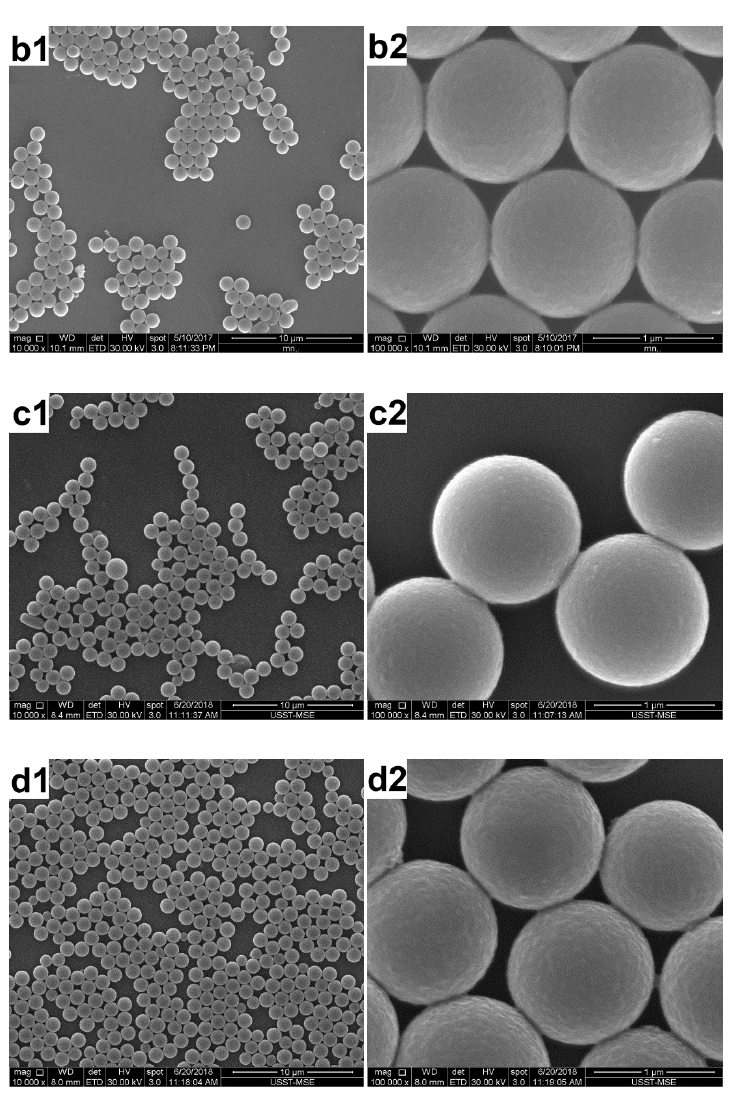
Figure 4. SEM images of the products prepared with a fixed amount of PS (0.4 g), and varied AT amounts at various magnifications: ( a ) 0.4 g (run 1); ( b ) 0.3 g (run 2), ( c ) 0.2 g (run 3); and ( d ) 0.1 g (run 4).